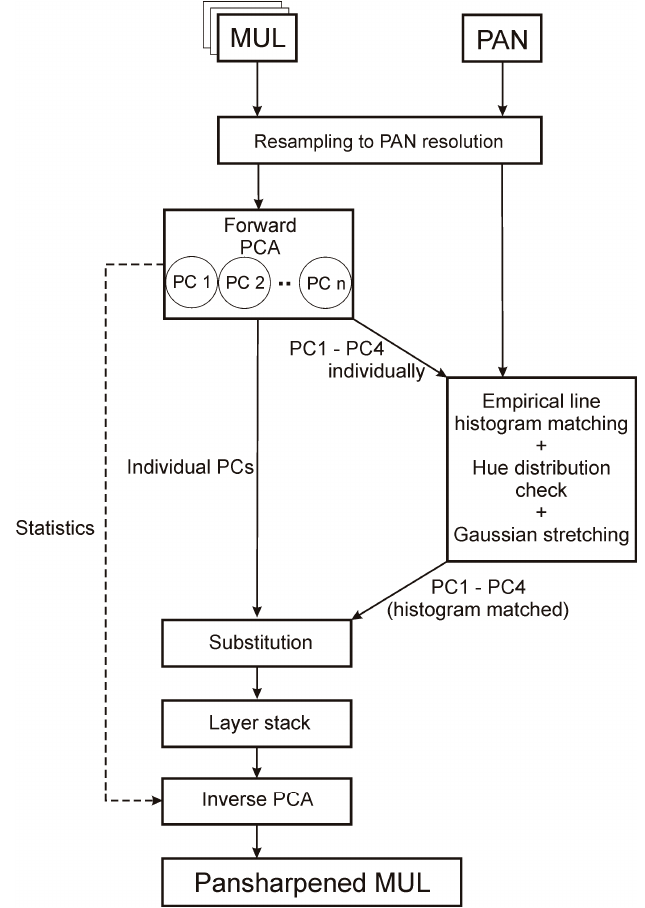
Figure 4. Processing scheme (MUL: multispectral ASTER data; PAN: panchromatic WV2 band; PC: Principal component; PCA: Principal component Analysis).